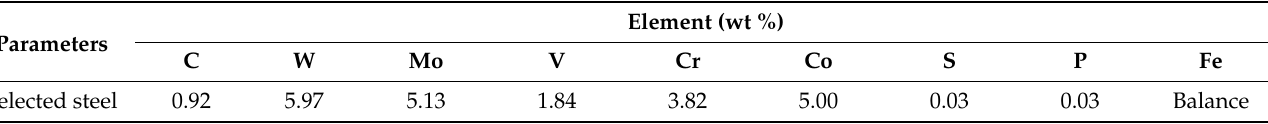
Table 1. Chemical composition of the AISI M35 high-speed steel.